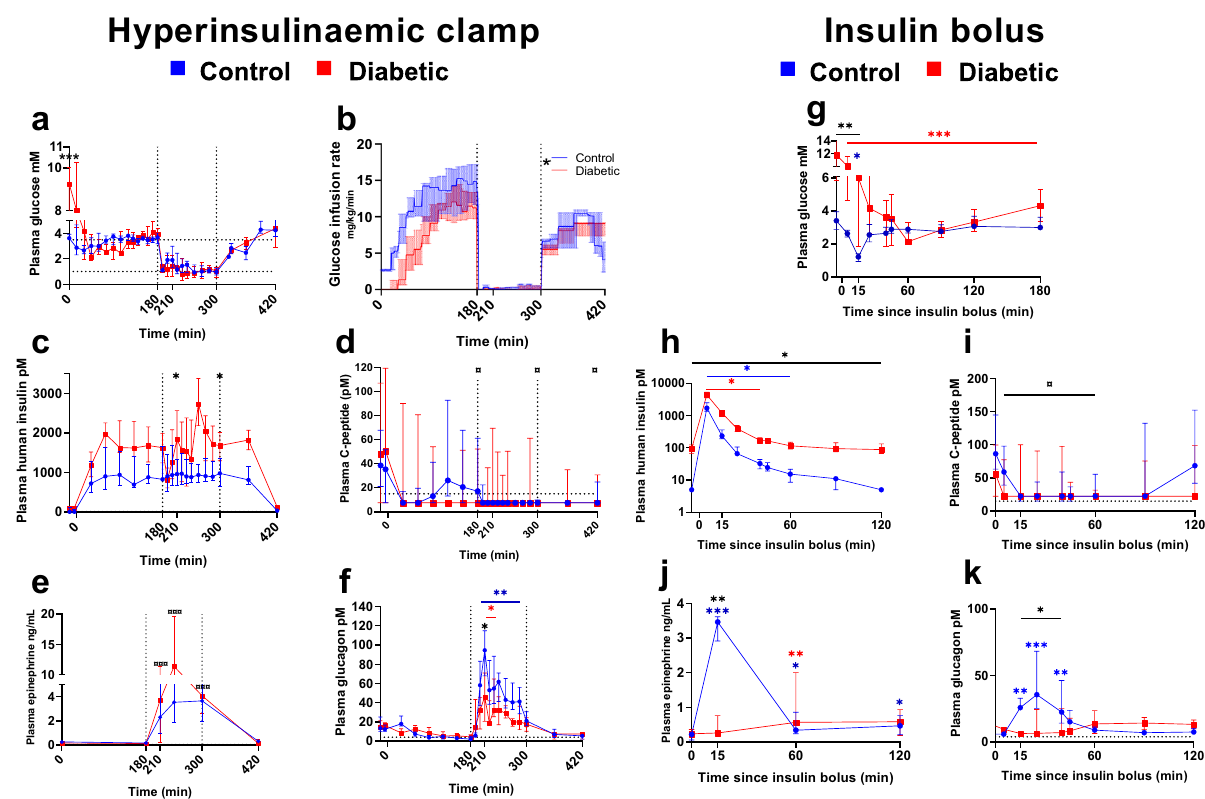
Figure 2. Endocrine response. Plasma glucose mM ( a + g ), human insulin pM ( c + h ), plasma C-peptide pM ( d + i ), plasma epinephrine ng/mL ( e + j ) and plasma glucagon pM ( f + k ), measured during the hyperinsulinaemic clamp and insulin bolus study. Glucose infusion rate during clamp in mg/kg/min ( b ). Clamp: blue lines: control pigs, red lines: diabetic pigs. Bolus: green lines: control pigs, orange lines: diabetic pigs. Data shown as medians ± interquartile range, except in glucose infusion rate, where each individual is illustrated. Significant difference to baseline within group is illustrated with accordingly colored stars (*), and, when both groups are considered together, as black currency sign ( ¤) . Significance between groups as black stars (*). * P < .05, ** P < .001, *** P < .0001, by linear mixed modelling or Mann–Whitney U-test. Horizontal dotted lines: lower limit of quantification of assay. Vertical lines: start and end of hypoglycaemia in the clamp. Software used to generate graphs: GraphPad Prism 8 (GraphPad Software Inc., San Diego,